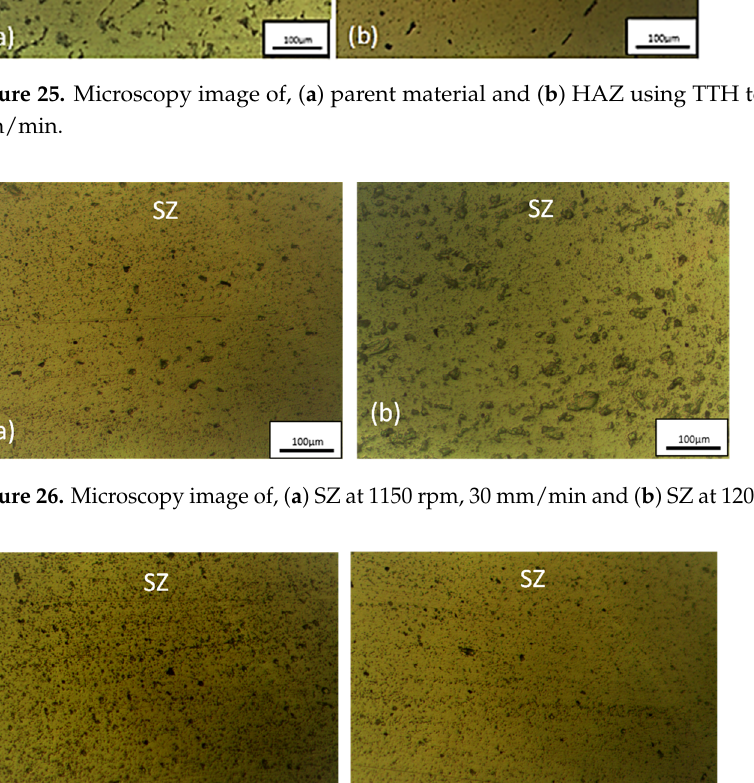
Figure 25. Microscopy image of, ( a ) parent material and ( b ) HAZ using TTH tool at 1200 rpm, 25 mm/min.